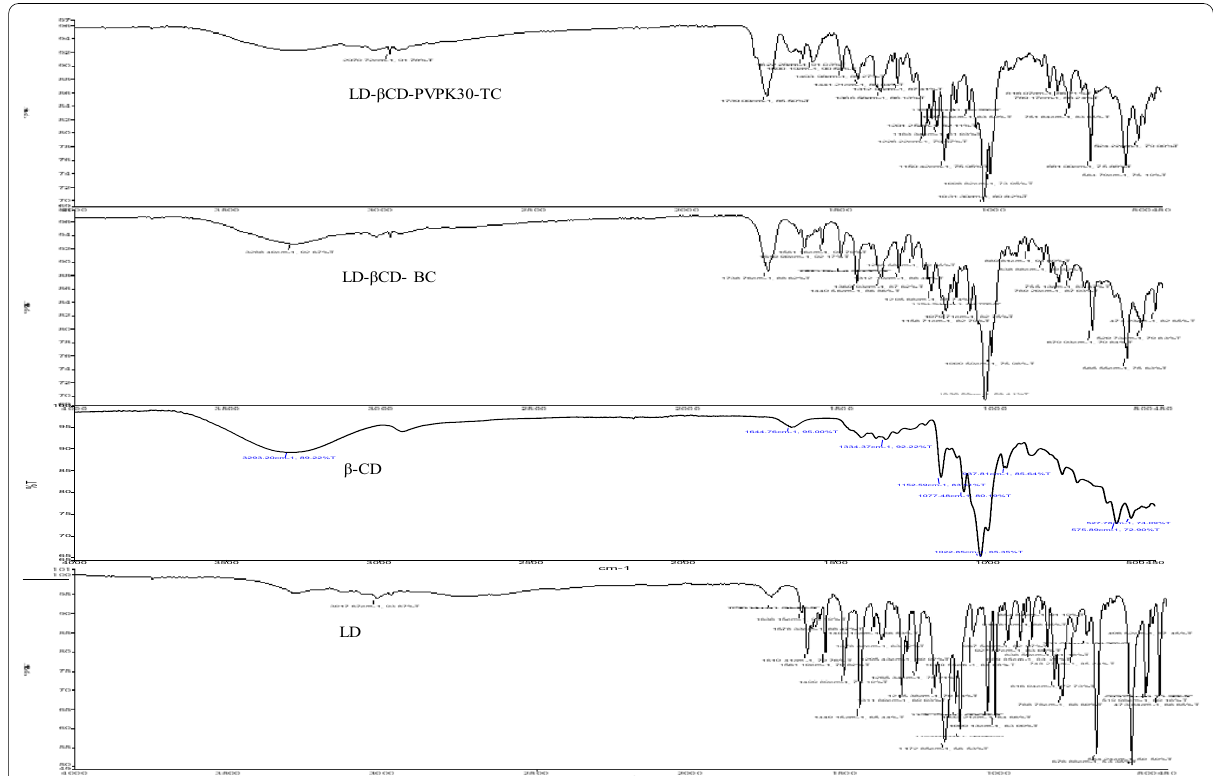
Fig. 12 FTIR spectra of LD, β-CD, binary and ternary systems, LD-βCD-BC,